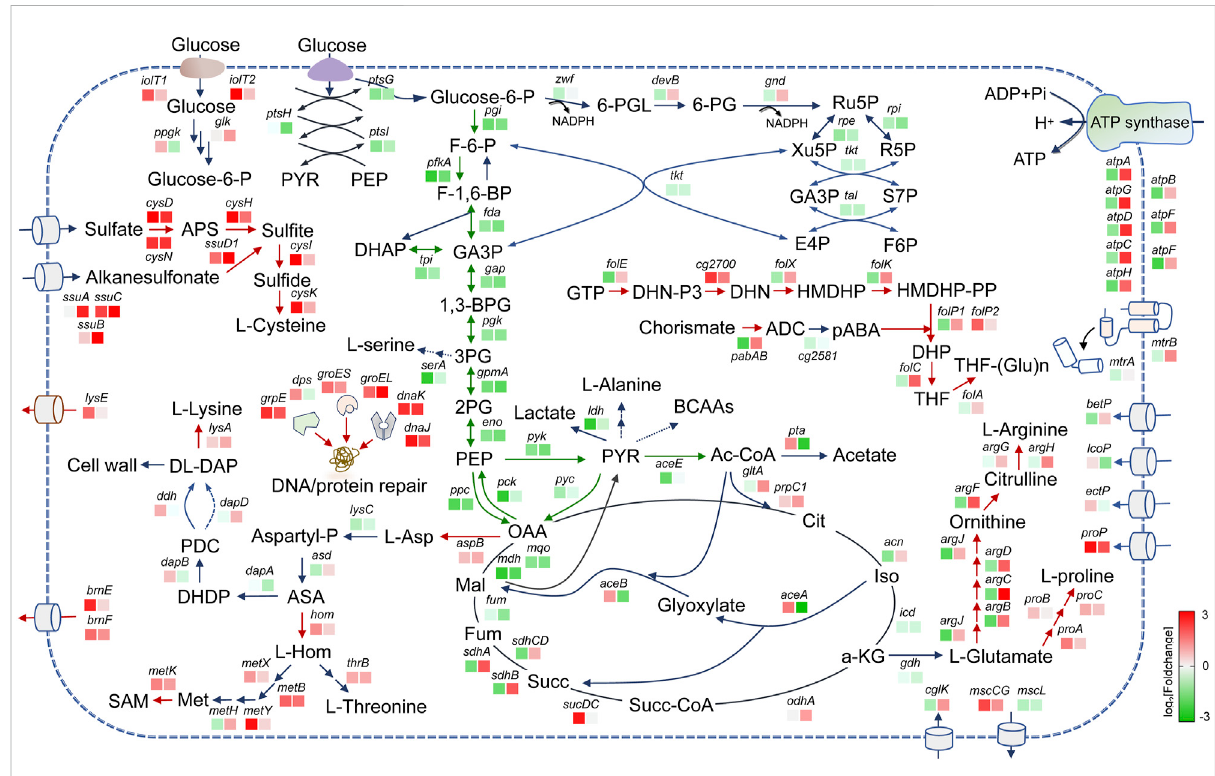
FIGURE 3 An overview of the major metabolic alterations affected by lysine treatment in C. glutamicum . Upregulated and downregulated genes are shown in red and blue, respectively. The color of the boxes represents the log 2 (fold-change) for genes shown. The left square box represents the short-term lysine-treated STsamples, and therightsquare boxrepresents thelong-term lysine-treatedHL samples. Note: glucose-6-P, glucose-6- phosphate; F-6-P, fructose6-phosphate; F-1,6-BP, fructose1,6-bisphosphate; DHAP, dihydroxyacetone phosphate; GA3P, glyceraldehyde 3- phosphate; 1,3-BPG, 1,3-bisphosphoglycerate; 3 PG, 3-phosphoglycerate; 2 PG, 2-phosphoglycerate; PEP, phosphoenolpyruvic acid; PYR, pyruvate; Ac-CoA, acetyl coenzyme A; 6-PGL, 6-phosphogluconolactone; 6-PG, 6-phosphogluconate; Ru5P, D -ribulose 5-phosphate; Xu5P, D -xylulose 5-phosphate; R5P, ribose 5-phosphate; S7P, sedoheptulose 7-phosphate; E4P, D -erythrose 4-phosphate; Cit, citrate; Iso, isocitrate; a-KG, alpha-ketoglutaric acid; Succ-CoA, succinyl coenzyme A; Succ, succinate; Fum, fumarate; Mal, L -malate; OAA, oxaloacetic acid; l-Asp, L -aspartate; Aspartyl-P, L-4-aspartyl phosphate; ASA, L -aspartate 4-semialdehyde; L-Hom, L -homoserine; DHDP, 2,3-dihydrodipicolinate; PDC, delta1-piperidine-2,6-dicarboxylate; DL-DAP, meso-diaminoheptanedioate; Met, L -methionine; SAM, S-adenosyl- L -methionine; APS,